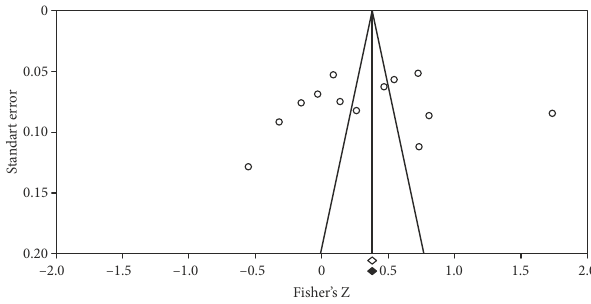
Figure 4. Funnel plot of risk-engineering harmony effect Table 2. The homogeneity test results of effect values (Q statistics)